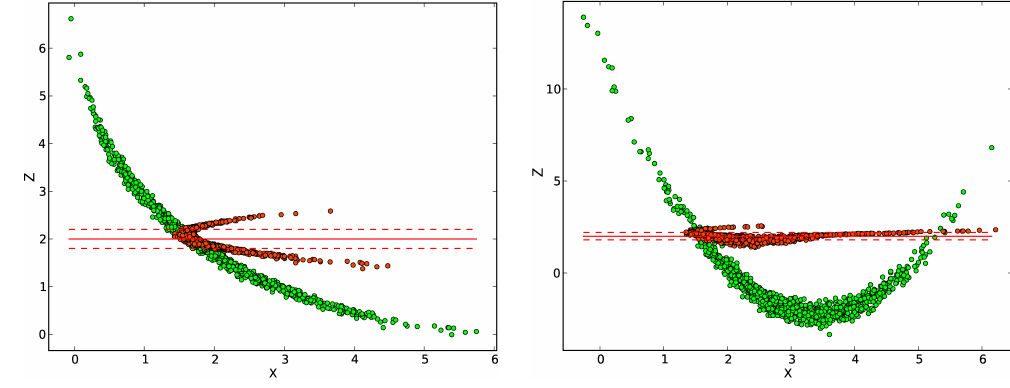
Fig. 3. Reconstruction of a density from an ensemble using the Rank Histogram approach.